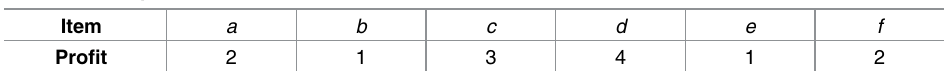
Table 2. A unit profit